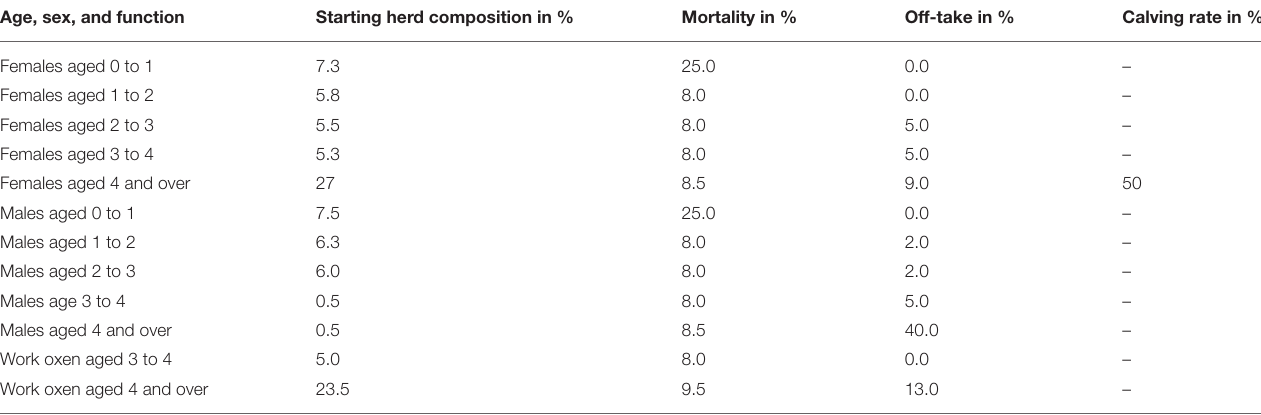
TABLE 1 | Cattle herd composition and production parameters used for the herd